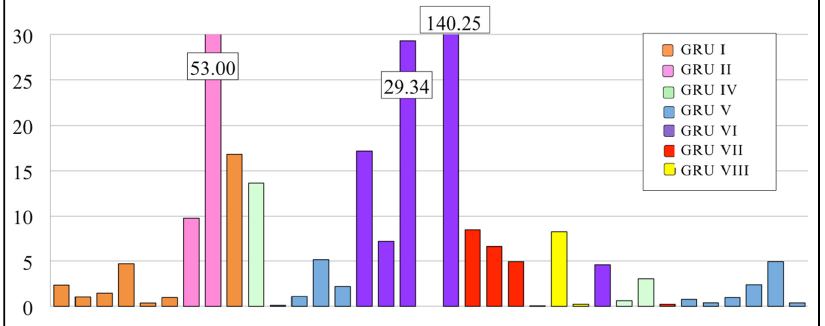
Figure 6. EPT/C ratio results for each sampling site in the Qu’Appelle River. The sampling sites are in order of upstream to downstream. The GRU of each site can be found in the legend.